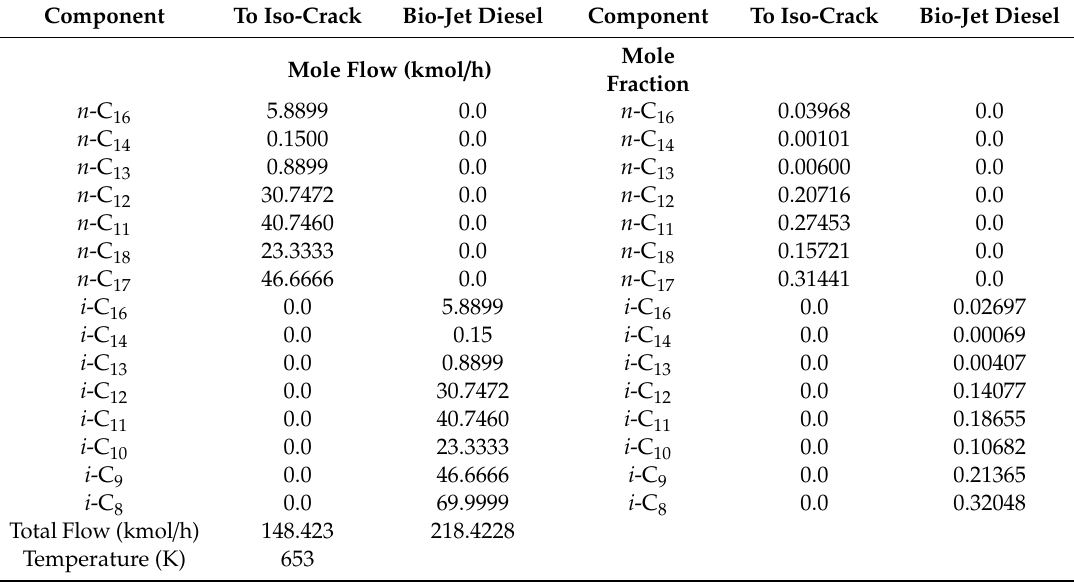
Table 4. Simulation results of the isomerization-cracking section in ASPEN-PLUS (reference